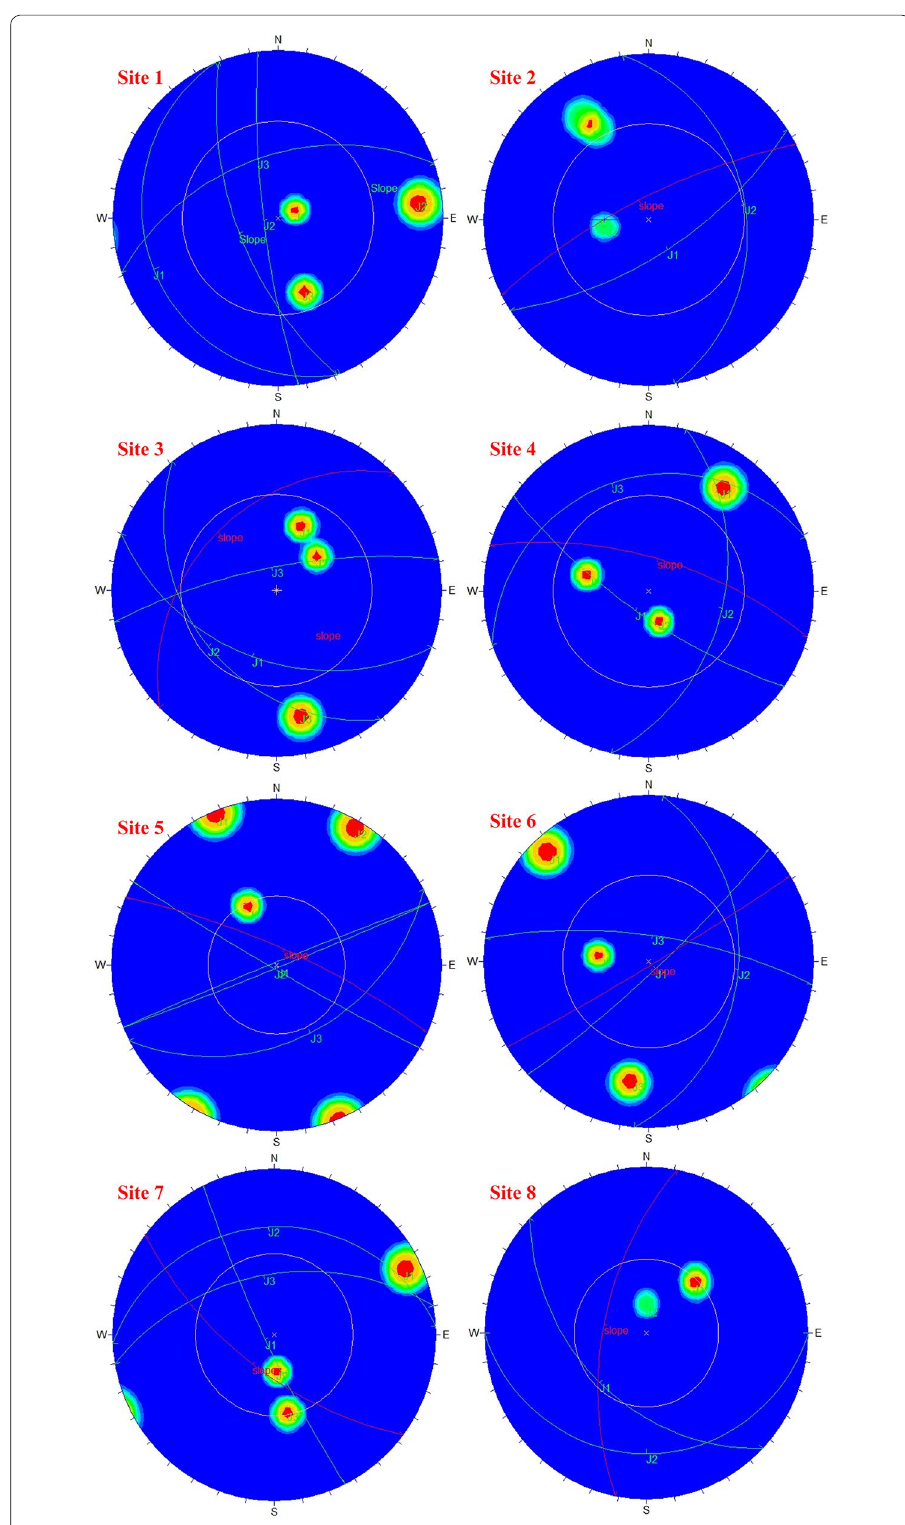
Fig. 4 Kinematic analysis of rockfall-prone